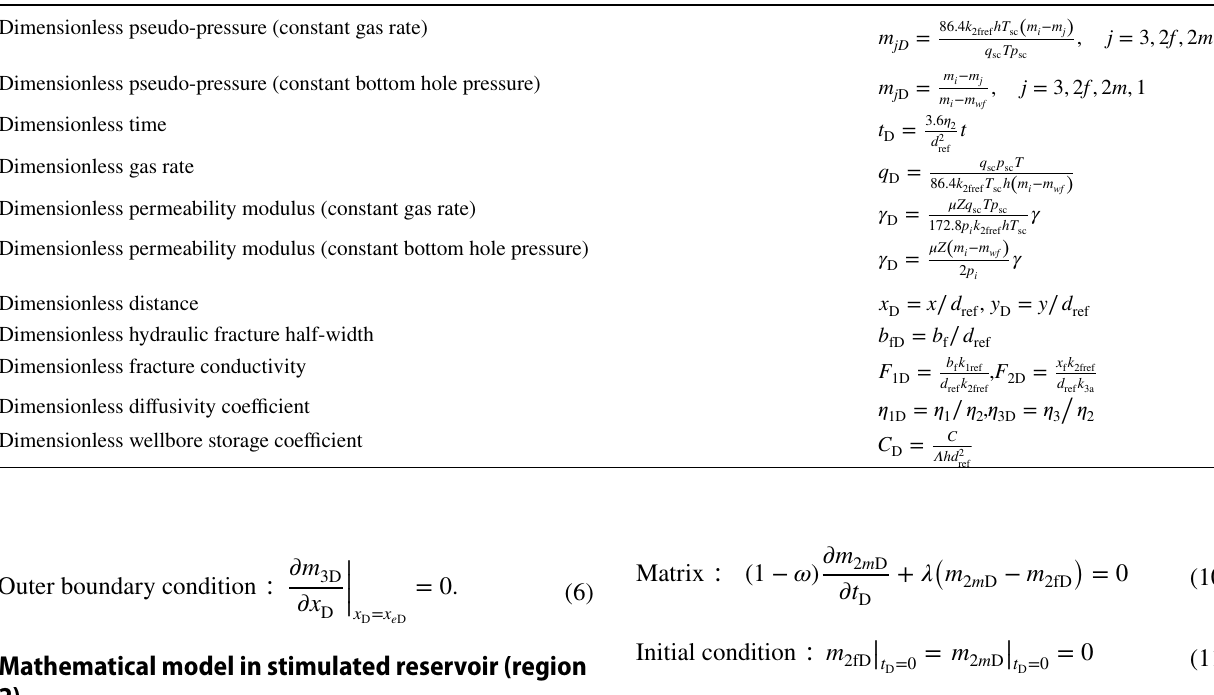
Table 1 Definitions of dimensionless variables Dimensionless pseudo-pressure (constant gas rate) Dimensionless pseudo-pressure (constant bottom hole